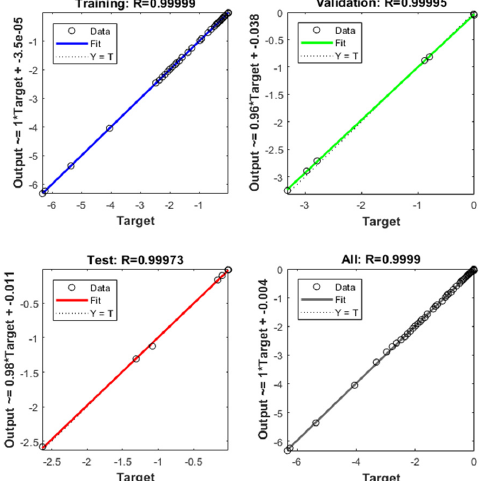
Figure 14. The correlation value of laboratory data and the ANN method (SRC beam).